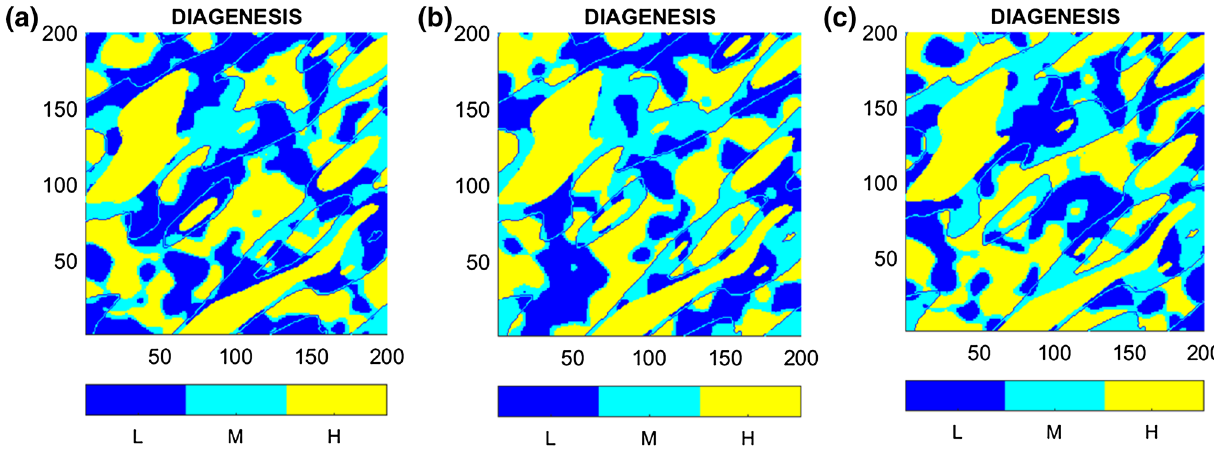
Fig. 10 a DR1 with gradual parameter of 0. b DR2 with gradual parameter of 0.5. c DR3 with gradual parameter of 1. The lines overimposed on the figures indicate the boundaries of